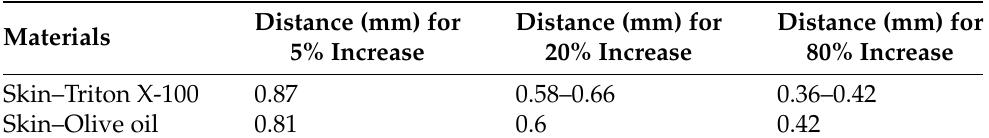
Table 7. Specified three levels for measured relative permittivity of skin–triton X-100 and skin–olive oil configurations at 0.5, 1, 2.04, 4.02 and 6 GHz frequency points.